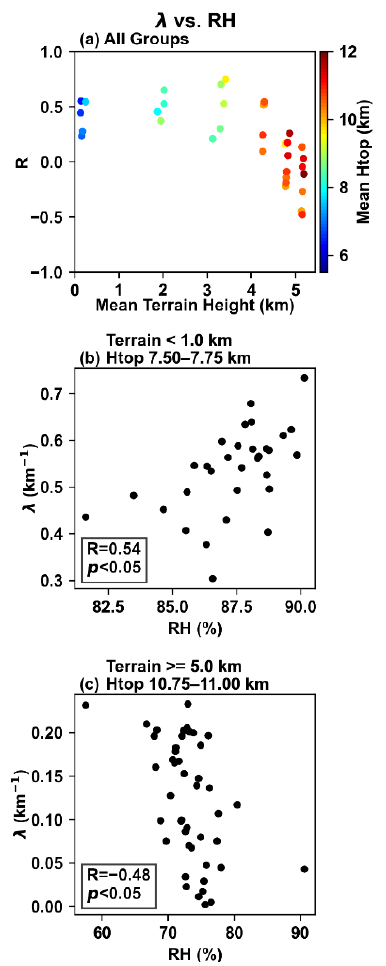
Figure 5. The correlation coefficients (R) of entrainment rate ( λ ; units: km – 1 ) with cloud base environmental relative humidity (RH; units: %) in the different cloud groups (Panel a ), and the relationship between the λ and RH in the representative cloud groups (Panels b , c ); the color bar denotes the mean cloud top height in each group.